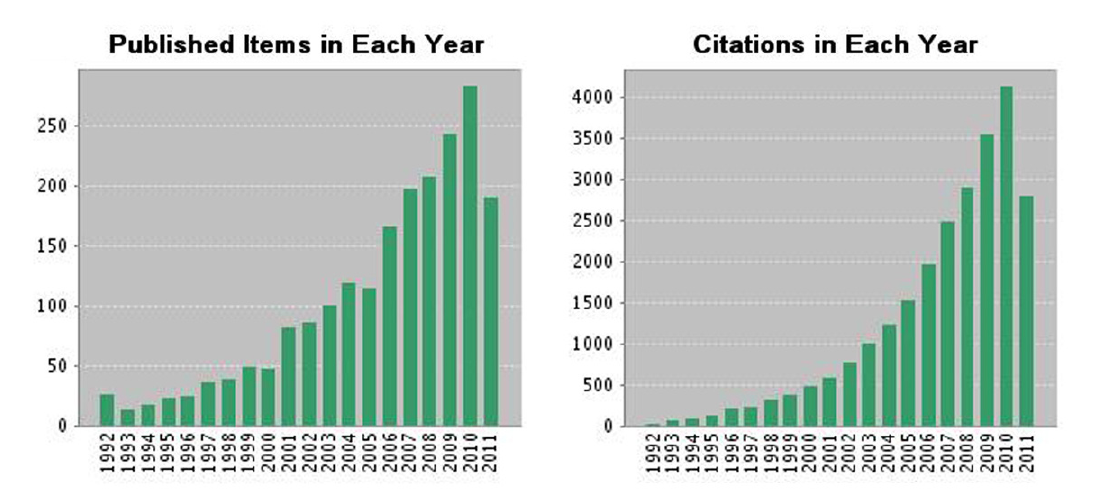
Figure 1. Evolution of the number of publications and citations in each year based on “ultrasound extraction” (source ISI Web of Science